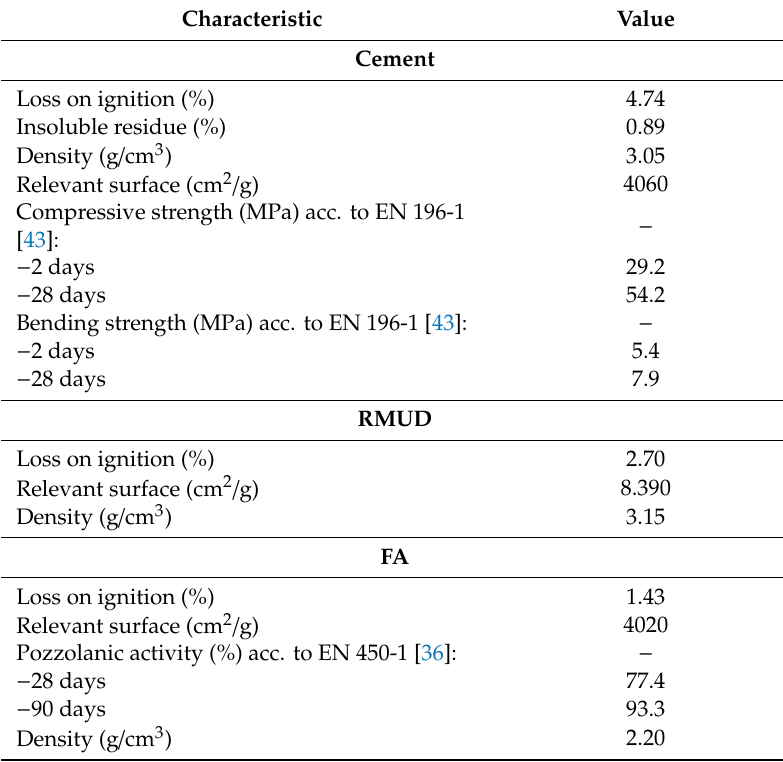
Table 2. Physio-mechanical characteristics of cement, RMUD, and FA